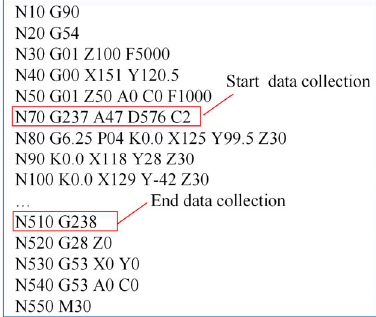
Figure 15. Partial G code for finishing S ‐ shaped edge trip.